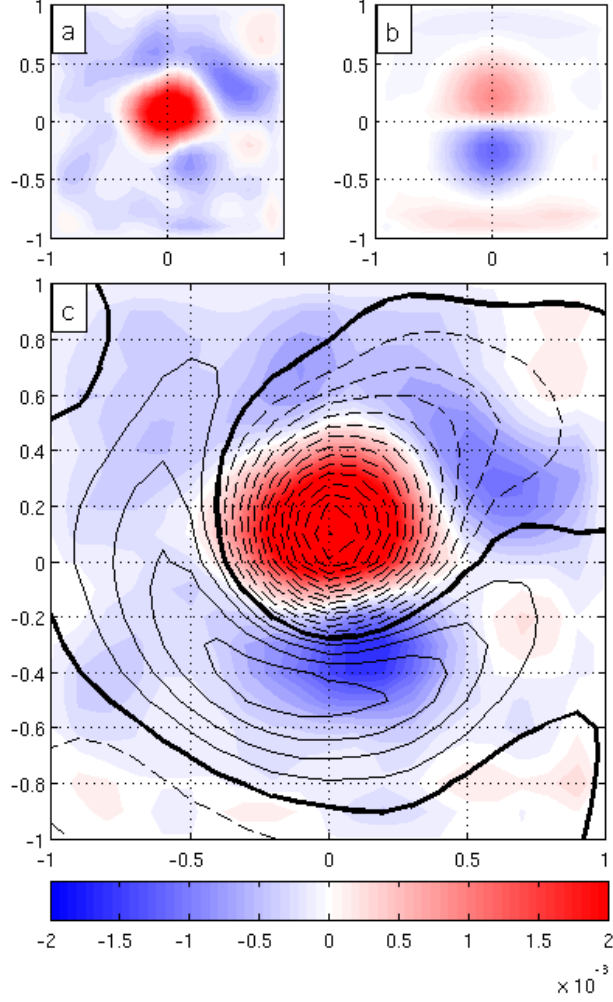
Figure 11. Results obtained for (a) term 1, (b) term 2 and (c) the to- tal Ekman pumping velocity w EK (mday − 1 ) for the mean estimated Agulhas ring. A remarkable concordance is observed between the mean vertical velocities (color contours) and the observed mean T 0 (black contours – c.i. 0.01 ◦ C). The w EK is dominated by the ( ∇ × τ ) 0 (term1), though the ( ∇ × ζ ) 0 (term 2) makes an impor- tant contribution. The figures’ axes represent the distances from the eddy center normalized by the eddy